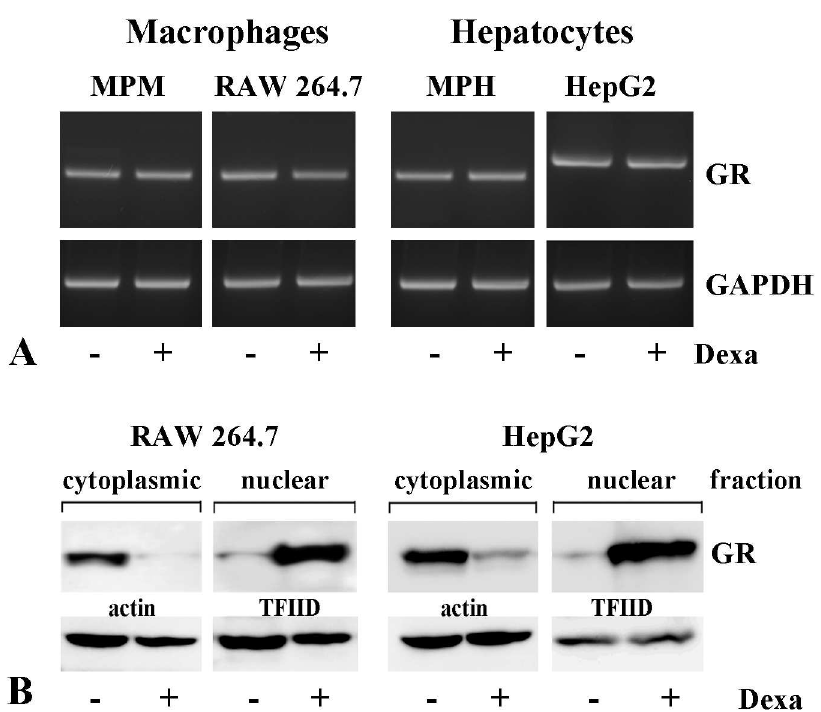
Fig 4. Glucocorticoid receptor (GR) expression and intracellular distribution in macrophages and hepatocytes upon dexamethasone treatment. (A) Macrophages (MPM, RAW 264.7) and hepatocytes (MPH, HepG2) express similar levels of GRs independently of dexamethasone treatment, as evaluatedby RT-PCR with GAPDH used as a reference gene. (B) Treatment of RAW 264.7 macrophages and HepG2 cells with 1 μ M dexamethasone for 24 hours leads to GR translocation into the cell nucleus,as detected by Western Blot; actin and TFIID were used as protein load controls for the cytoplasmic and nuclear fractions,